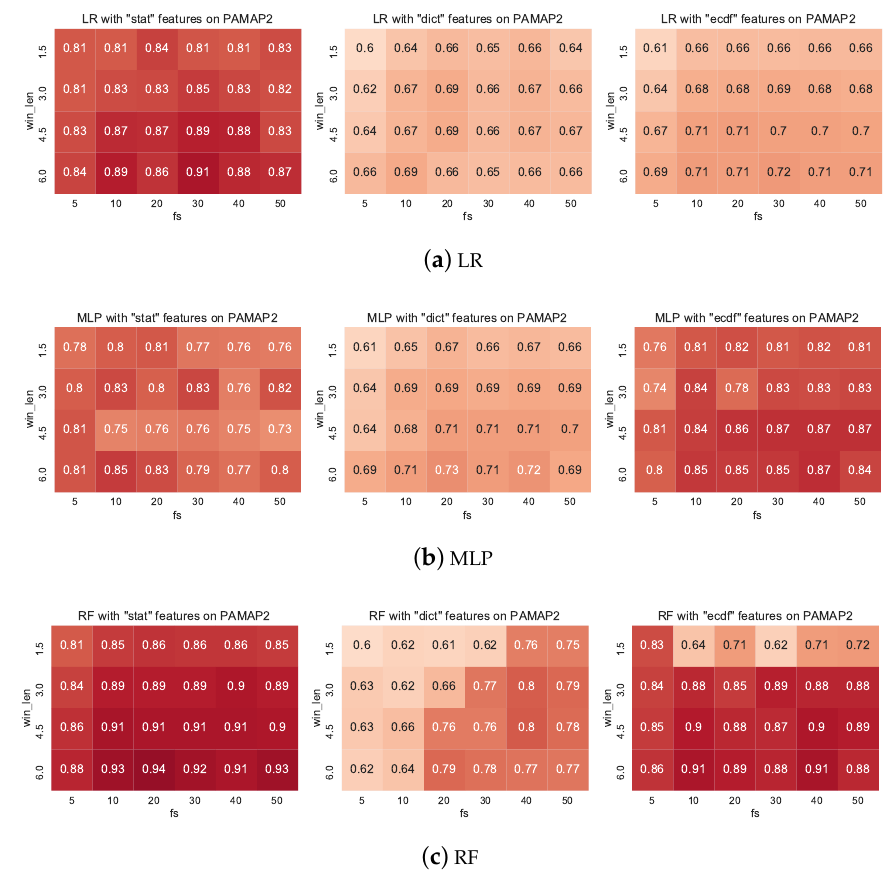
Figure A2. Classification performance on the PAMAP2 dataset with all iid feature